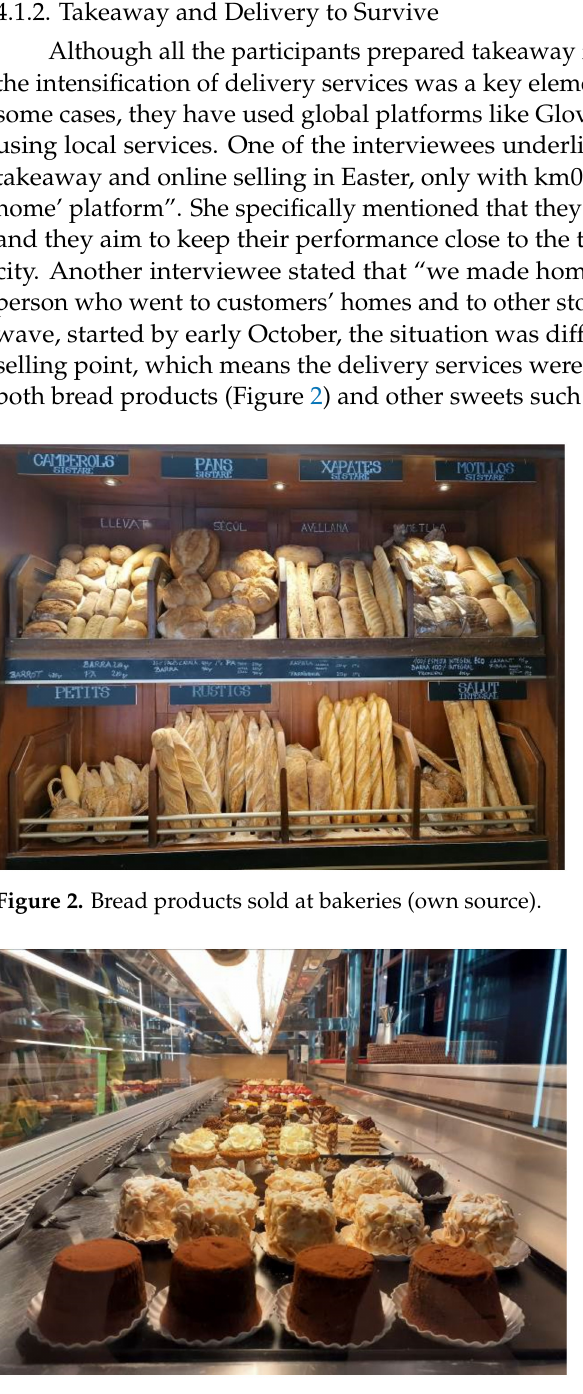
Figure 3. Non-bread products sold at bakeries (own